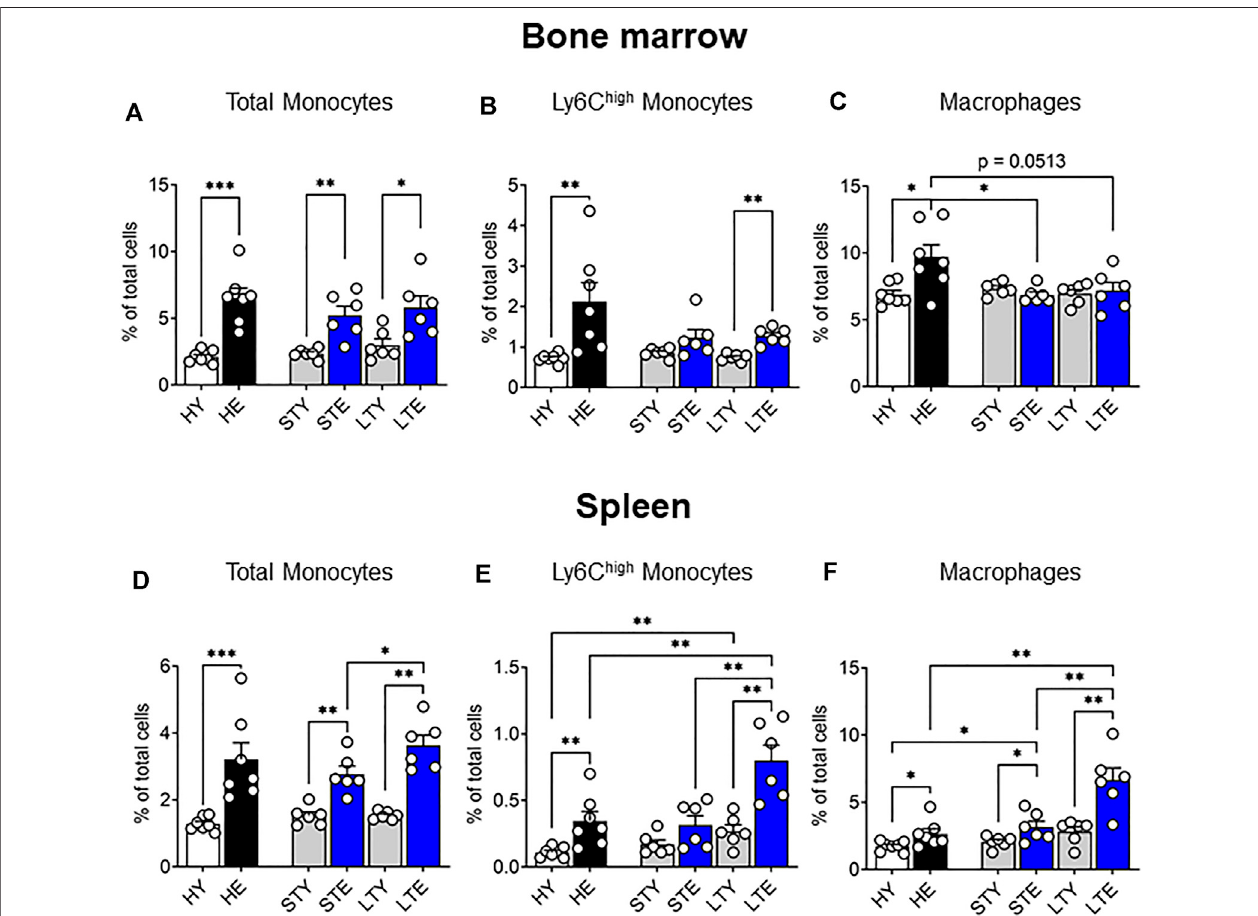
FIGURE 3 | Splenic monocyte and macrophage pools increase with age and is further exacerbated with tumor growth. Young and elderly C57BL/6J mice were inoculated with AE17 mesothelioma tumor cells and sacri fi ced when tumors were small (early time point, tumor size < 30 mm 2 ) or large (late time point, tumor size 65 – 140 mm 2 ). Total monocytes (CD11b + F4/80 neg Ly6G neg ), Ly6C high monocytes and macrophages (CD11b + F4/80 + Ly6G neg ) shown as percentage of total cells in the bone marrow [ (A − C) , respectively) and the spleen [ (D – F) , respectively). Data on healthy mice ( Figure 1 ) have been included here as controls. HY, healthy young; HE, healthy elderly; STY, small tumor young; STE, small tumor elderly; LTY, large tumor young; LTE, large tumor elderly. Data shown as mean ± SEM; n = 6 – 7 mice/ group; * p < 0.05, ** p <